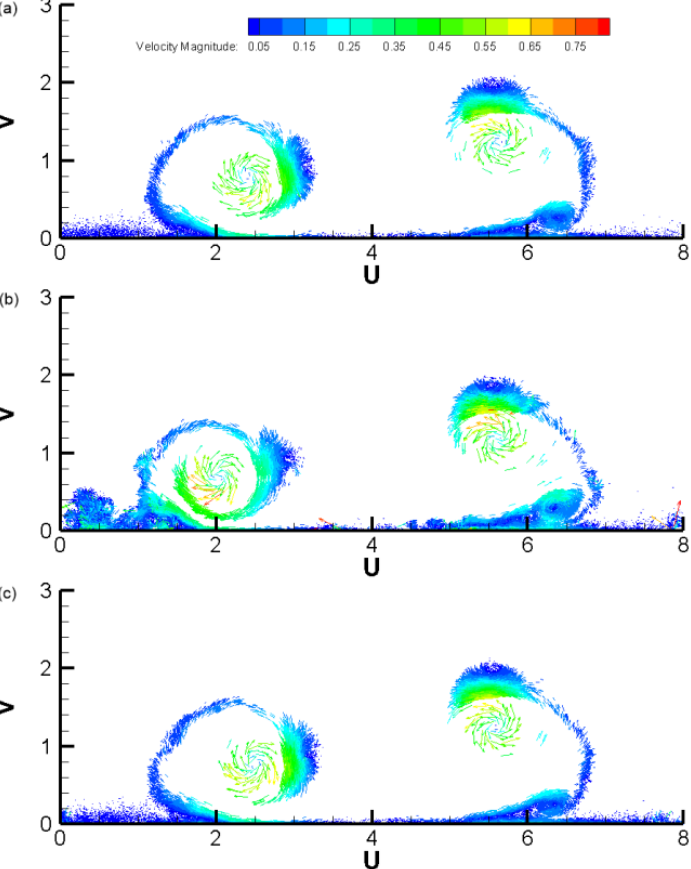
Figure 7. Instantaneous velocity field behaviors with buoyancy forces and without crosswind effects (T ∞ * = 20 ◦ C, Pr = 0.7, and Re = 7650) for: ( a ) t = 29.15 and Ri = 0.0; ( b ) t = 28.05 and Ri = 1.018; and ( c ) t = 29.00 and Ri = 2.036.